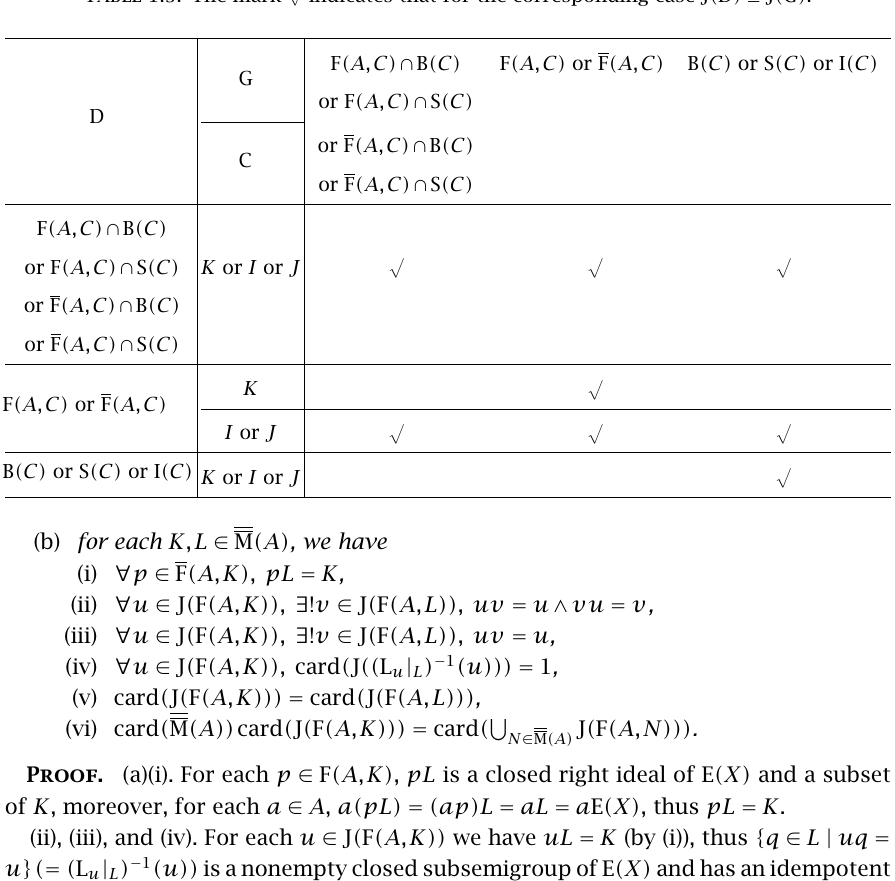
√ Table 1.3 . The mark indicates that for the corresponding case J ( D ) ⊆ J ( G ) .